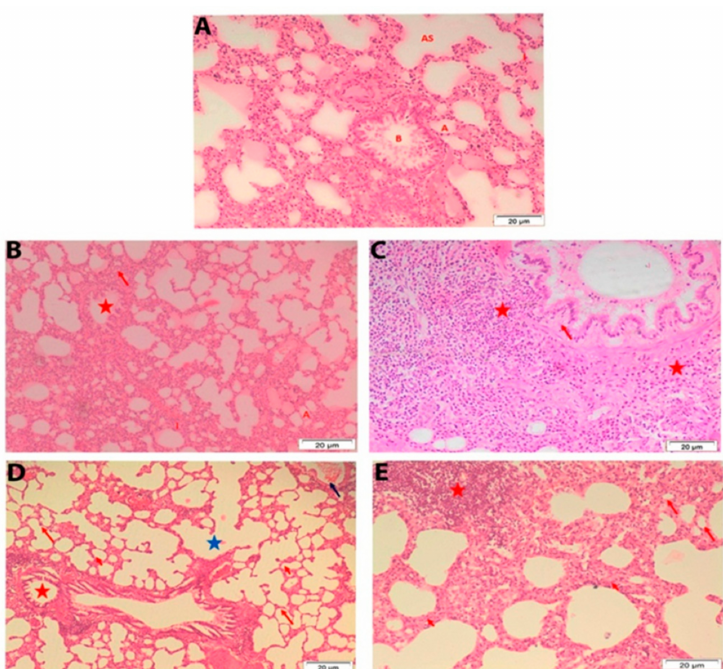
Figure 7. Histological analysis of the lung tissue in male rat exposed orally to single dose of 250 mg TiSiO 4 NPs/kg b.w. ( A ): male rat lung showing normal alveoli (red A) that lined with type I pneumocyte squamous cells (P1), type II pneumocyte cuboidal cells (P2), thin septa (red I), alveolar sacs (red AS) and bronchiole (red B). ( B , C ) male rat lung after 7 days post administration showing ( B ): some patent alveoli (red A), moderate cellular infiltration (red arrow) in the septa and the adventitia of distended bronchiole, and moderate thickened septa; ( C ): some patent alveoli, moderate cellular infiltration (red asterisk) in the septa and the adventitia of distended bronchiole (red arrow), and moderate thickened septa (red arrowhead). ( D , E ) male rat lung after 28 days post administration showing ( D ): alveoli (red arrow heads) with thin septa (red arrows) and alveolar sacs (blue asterisk), normal bronchiole (red asterisk) and thickened blood vessels wall (blue arrow). ( E ): collapsed alveoli wall (red arrow), heavy cellular infiltration in intra alveolar spaces (red asterisk) and markedly thickened septa (red arrow